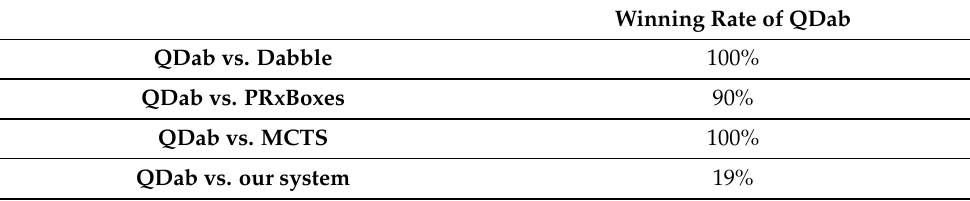
Table 6. Winning rate